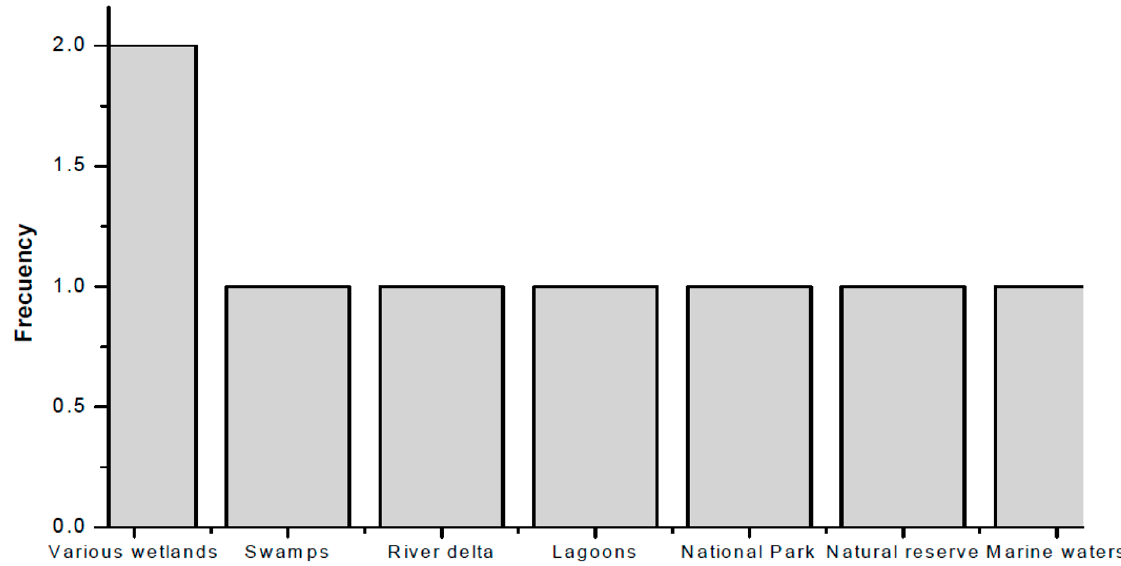
Figure 10. Frequency Distribution of the Types of Wetlands Affected in